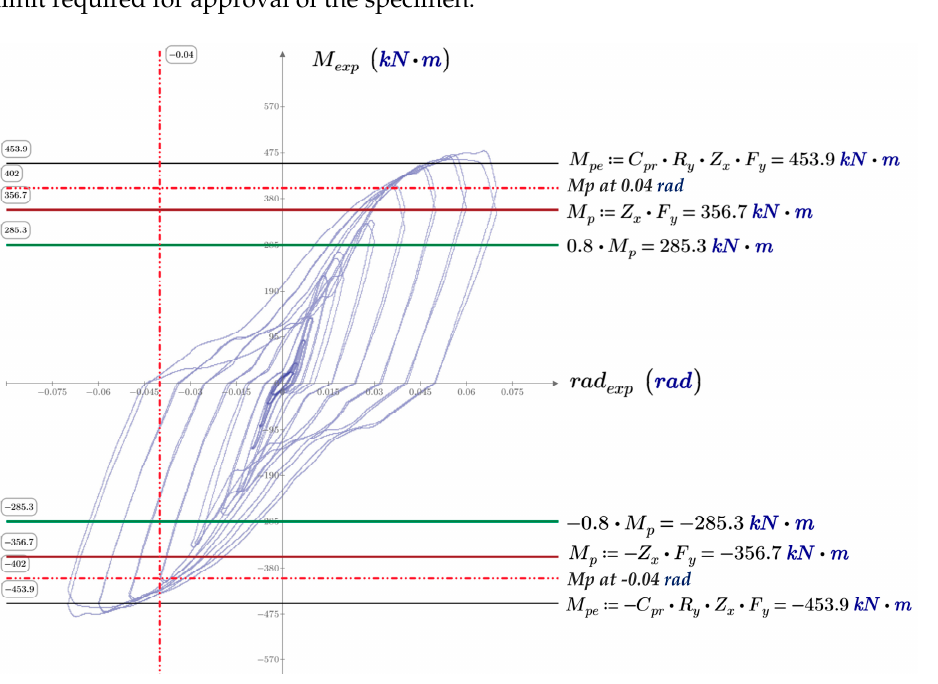
Figure 7. Hysteretic curve (moment–angle).